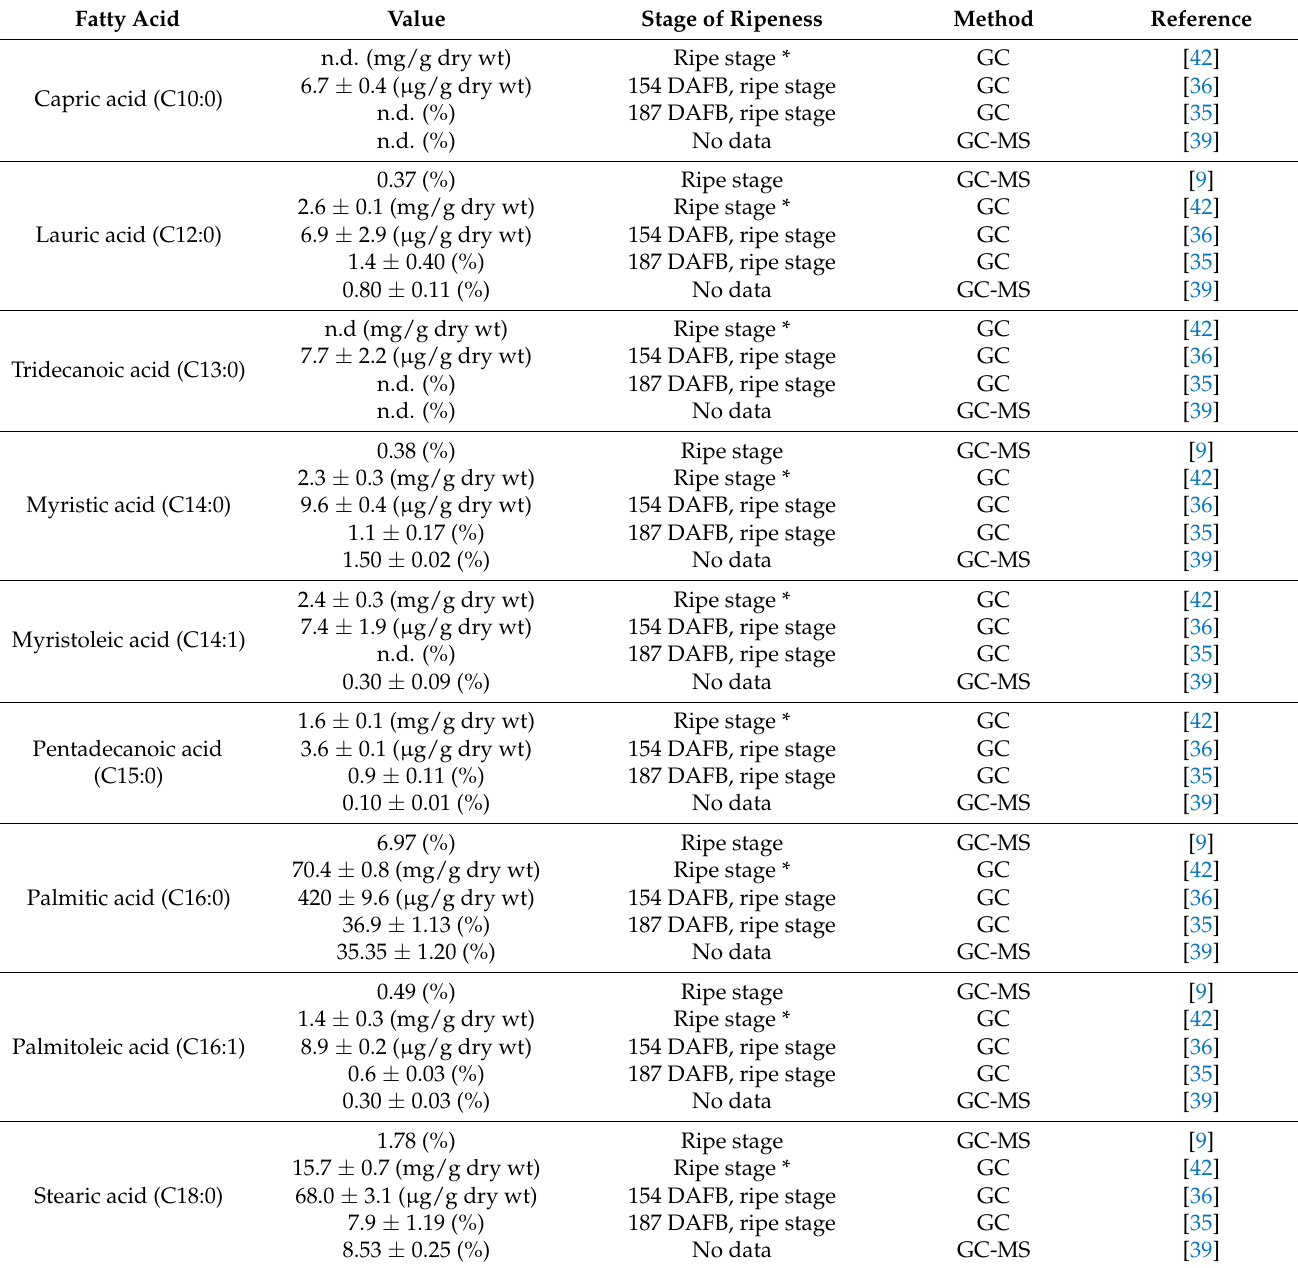
Table 7. Fatty acids composition of medlar